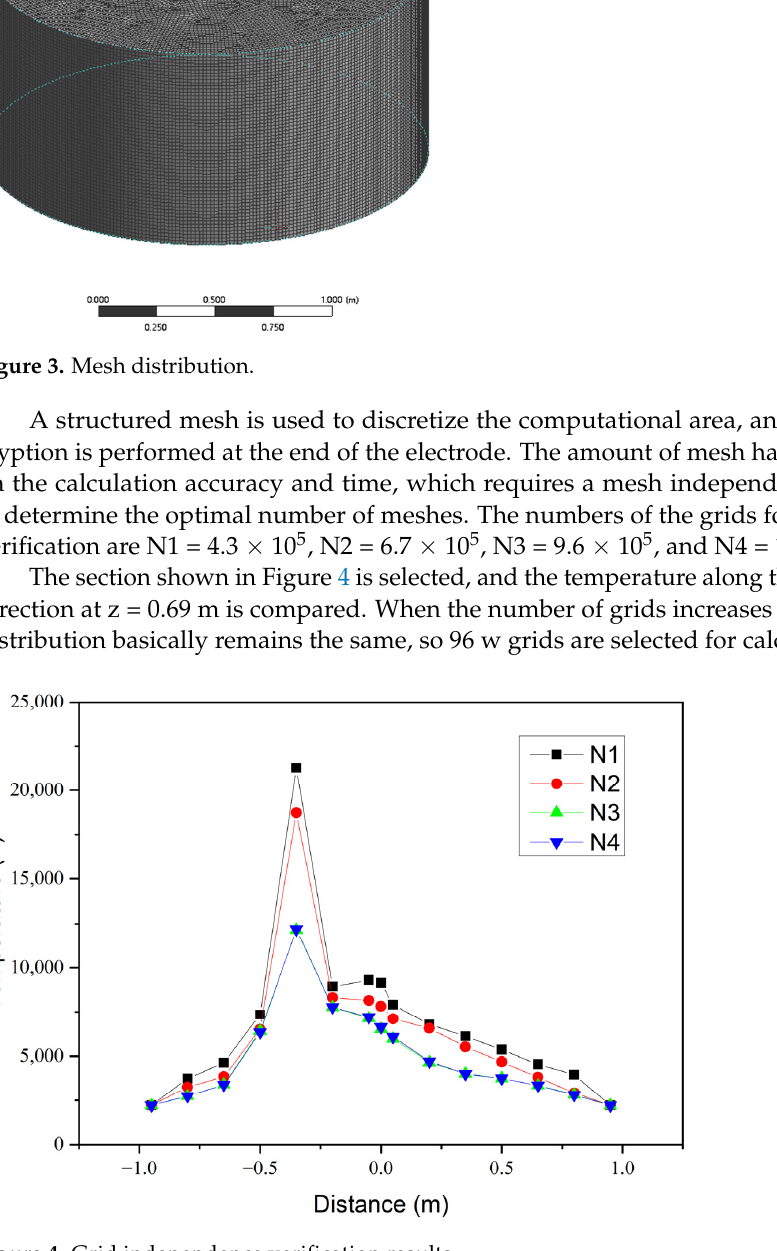
Figure 5. Accuracy verification.